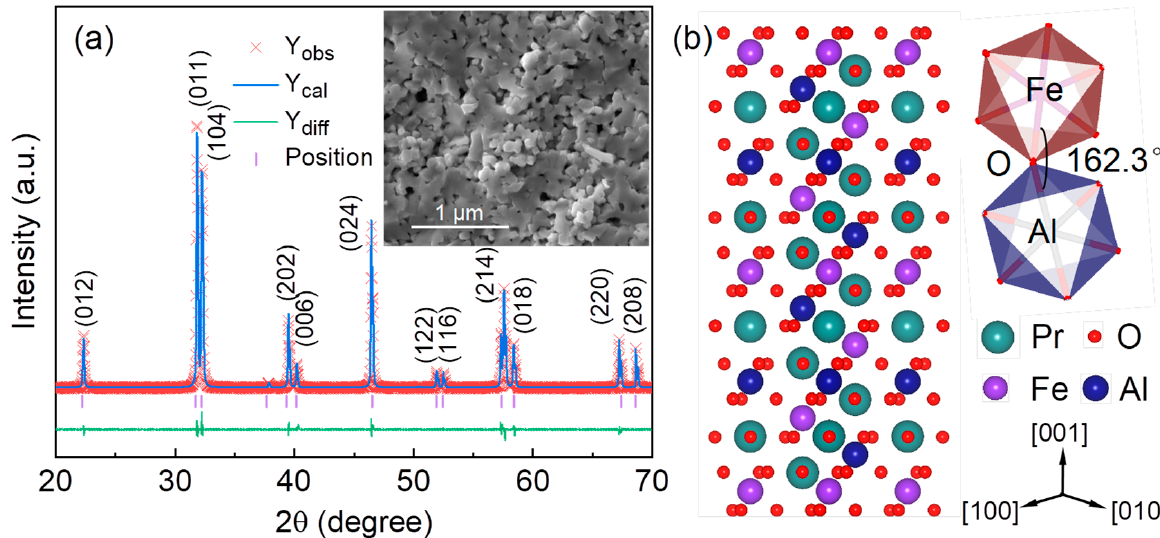
Figure 1. ( a ) X-ray diffraction pattern of Pr 2 FeAlO 6 ceramic. Inset shows the SEM image. ( b ) The crystal structure of double perovskite Pr 2 FeAlO 6 . The crystallographic is constructed by the crystal structure visualization software (Diamond) and the lattice constants are obtained from the Rietveld structure refinement.